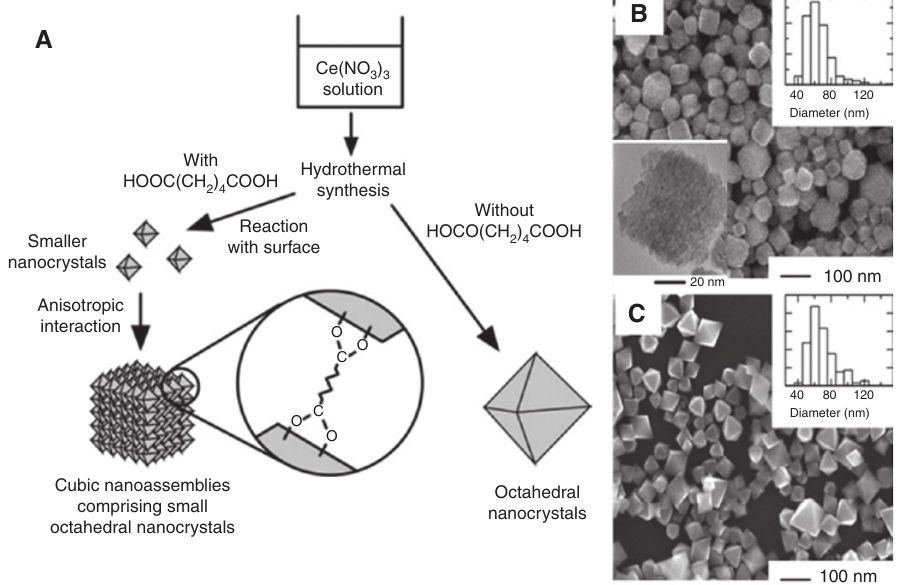
Figure 18: Principle of the hydrothermal synthesis of ceria NCs (A), in the presence (B) or absence (C) of hexanedioic acid. Reprinted with permission from Takami S, Ohara S, Adschiri T, Wakayama Y, Chikyow T, Dalton Trans. 2008, 5442–5446 [96], Copyright 2008 Royal Society of